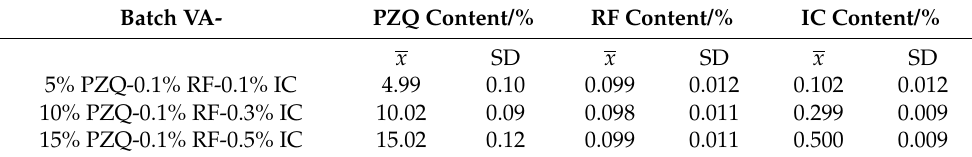
Table 5. Content of coloring agents determined by HPLC